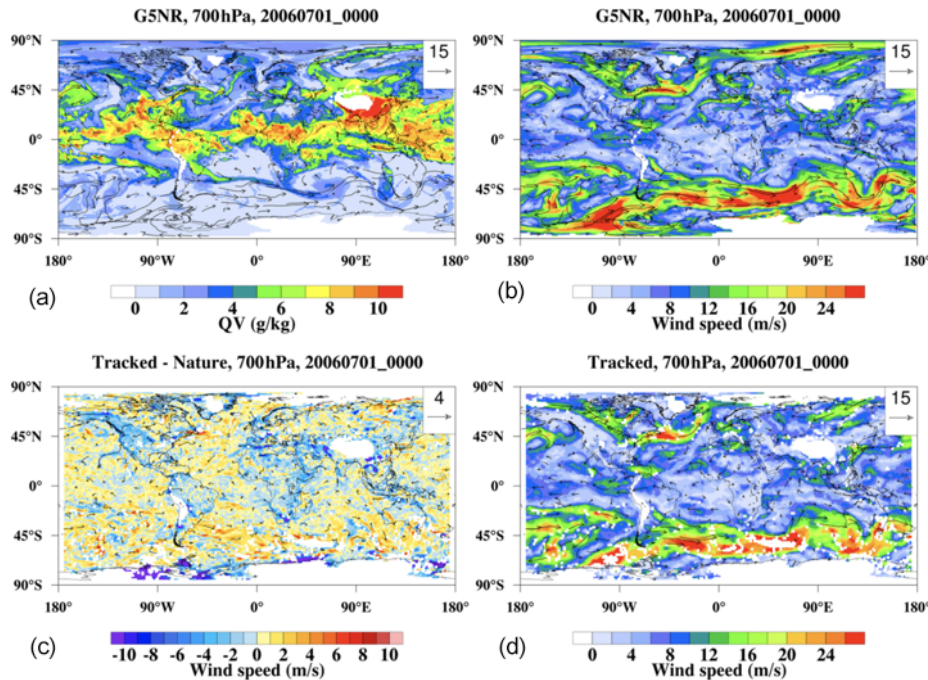
Figure 1. Map of Nature Run at one time step at 700hPa. (a) Water vapor; (b) Nature Run wind speed; (c) difference between Nature Run wind speed and AMV estimate; (d) AMV